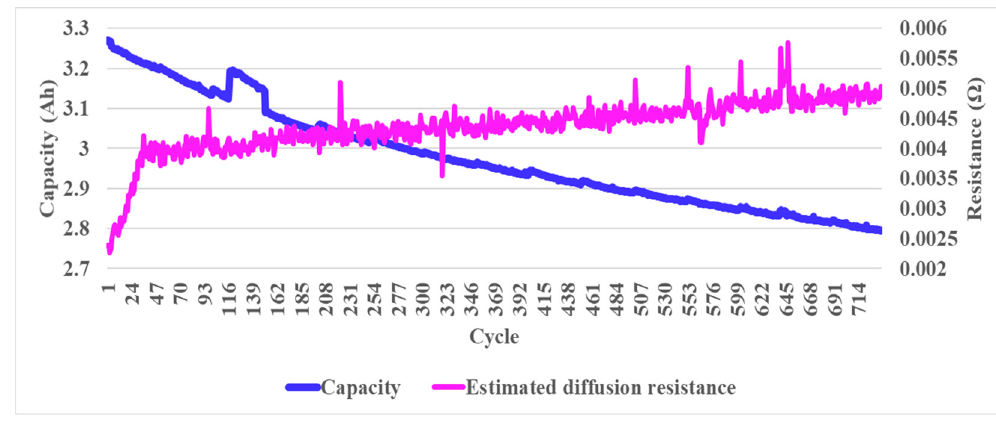
( b ) Relationship between diffusion resistance and capacity. Figure 7. Relationship between capacity and resistance. Figure 7. Relationship between capacity and resistance.